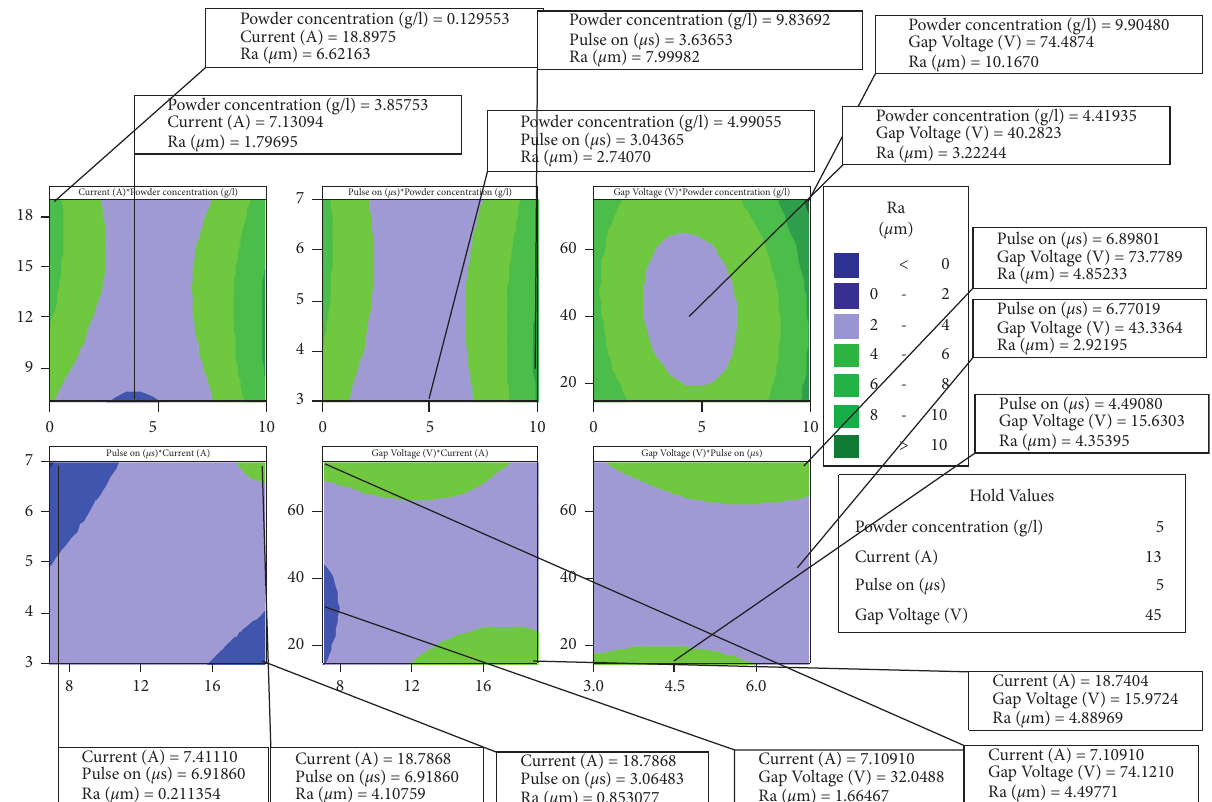
Figure 6: Interaction plot impact of distinct input variables vs. R